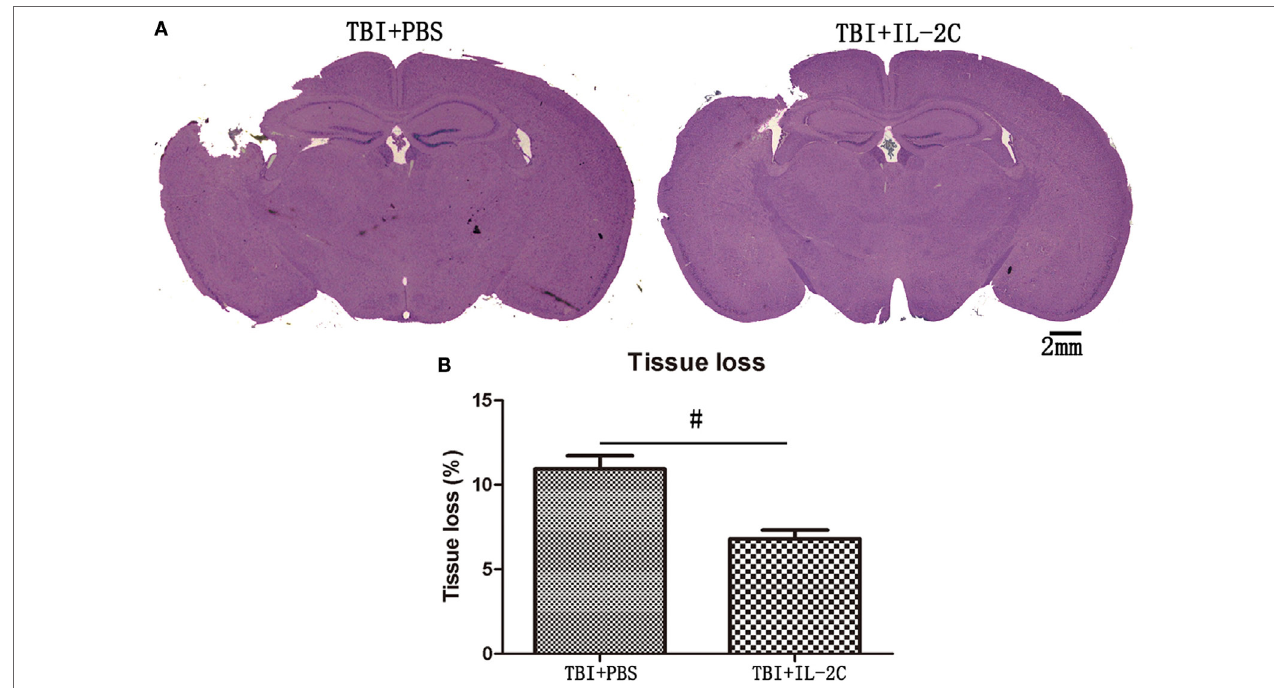
FigUre 7 | (a) Representative Mayer’s Hematoxylin and Eosin-stained brain sections obtained from PBS and IL-2C-treated mice at 7 days post-traumatic brain injury (TBI) (scale bar = 2 mm). (B) The bar graph shows that treatment with IL-2C resulted in significantly less tissue loss than was observed in the control ( n = 5 mice/group). Data are presented as the mean ± SD; * p < 0.05 and # p < 0.01.